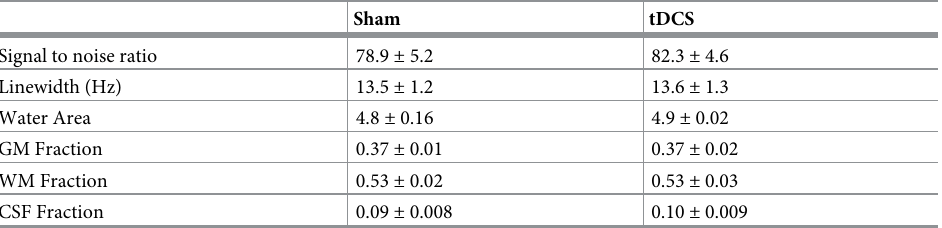
Table 1. Spectral quality and quantification: Characterization of spectral quality and voxel tissue composition. Signal to noise ratio represents the intensity of the NAA CH3 peak divided by the standard deviation of the baseline noise after Fourier transformation of the initial 0.3 seconds. The linewidth represents the full width at half maximum (FWHM) of the unsuppressed water signal. The water area represents the area of the unsuppressed water spectrum. The voxel tissue partial volume is provided for gray matter (GM), white matter (WM) and cerebral spinal fluid (CSF). Data is presented as mean ± standard error of the mean. Repeated measured t-tests were conducted on all spectral parameters; no significant changes between sham and stimulation were observed.